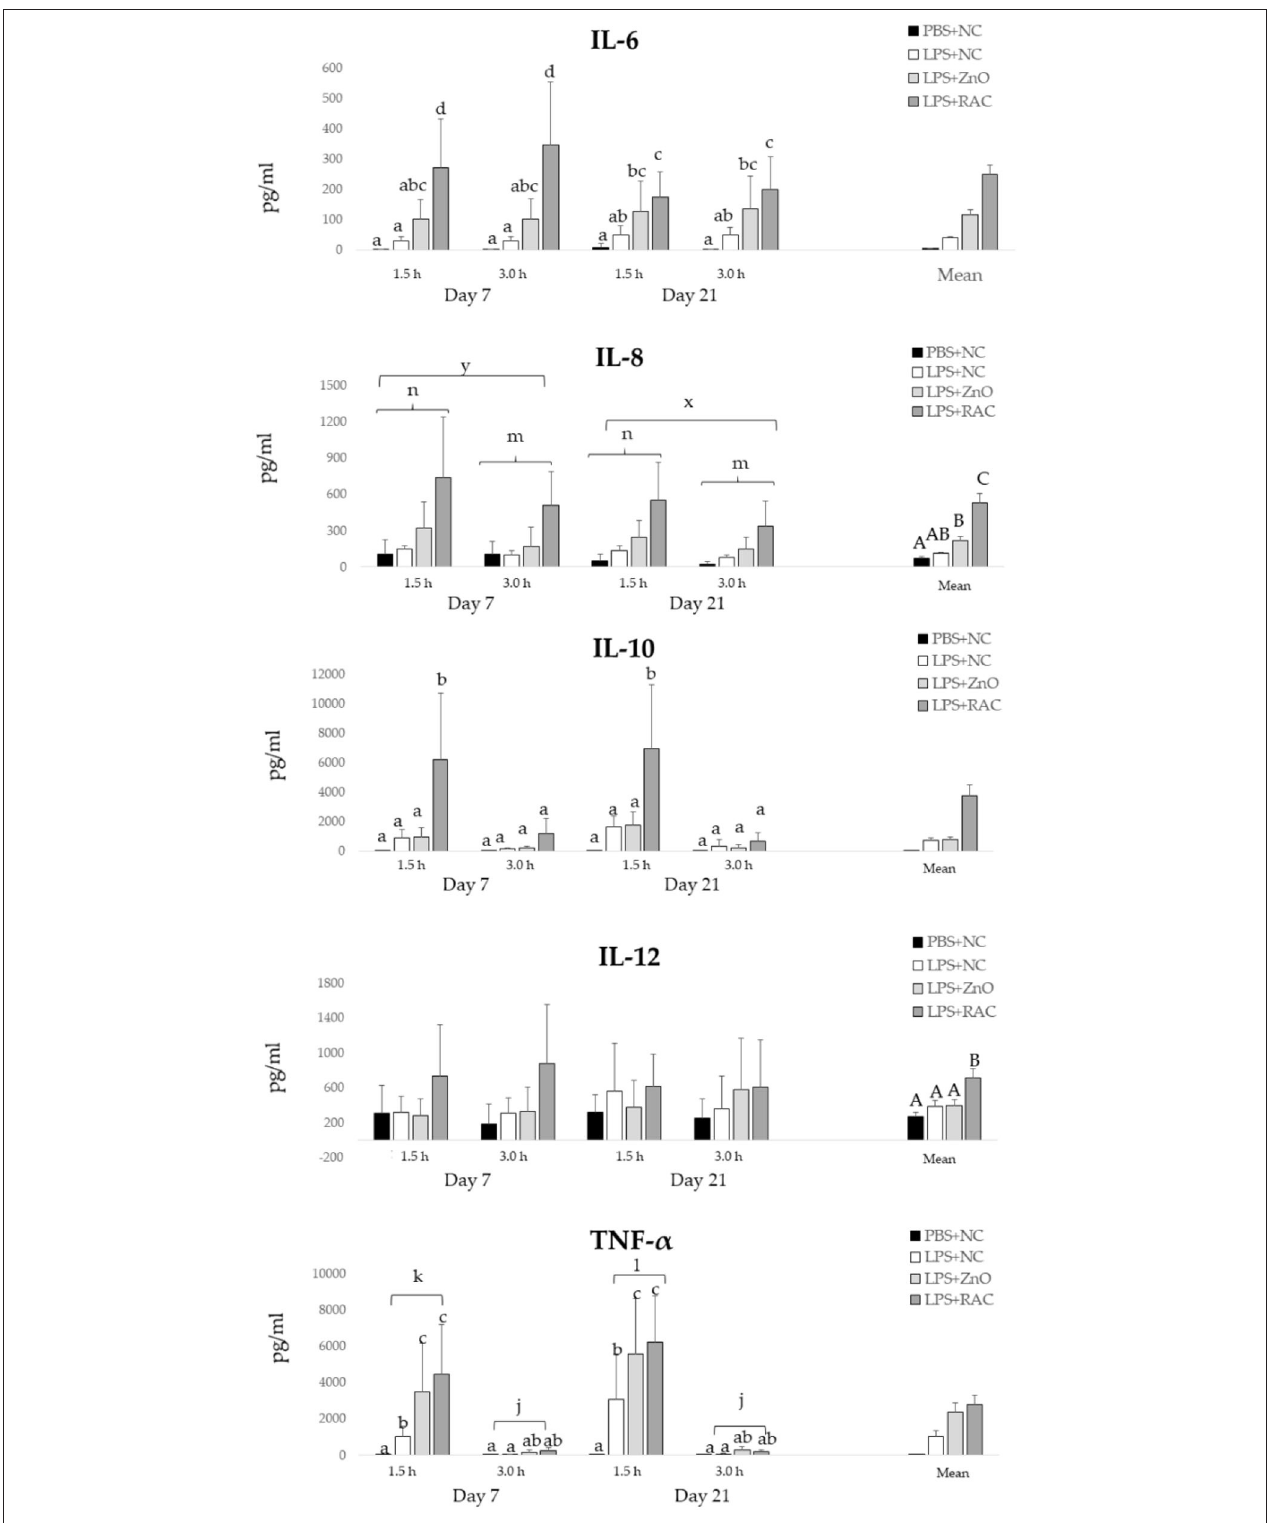
FIGURE 2 | Mean ( ± SEM) serum levels of IL-6, IL-8, IL-10, IL-12, and TNF- α in piglets from the PBS + NC, LPS + NC, LPS + ZnO, and LPS + RAC groups. a − d Different superscripts indicate significant differences among treatments and day or sampling time ( P ≤ 0.05), A − C Different superscripts indicate significant differences among treatments ( P ≤ 0.05), x,y Different superscripts indicate significant differences among days ( P ≤ 0.05), m,n Different superscripts indicate significant differences among sampling time ( P ≤ 0.05), j − l Different superscripts indicate significant differences among day and sampling time ( P ≤ 0.05) 1 . 1 Blood samples were collected from all piglets ( n = 48) on days 7 and 21 post-weaning, and at 1.5 and 3.0h post i.m. injection of PBS or LPS.